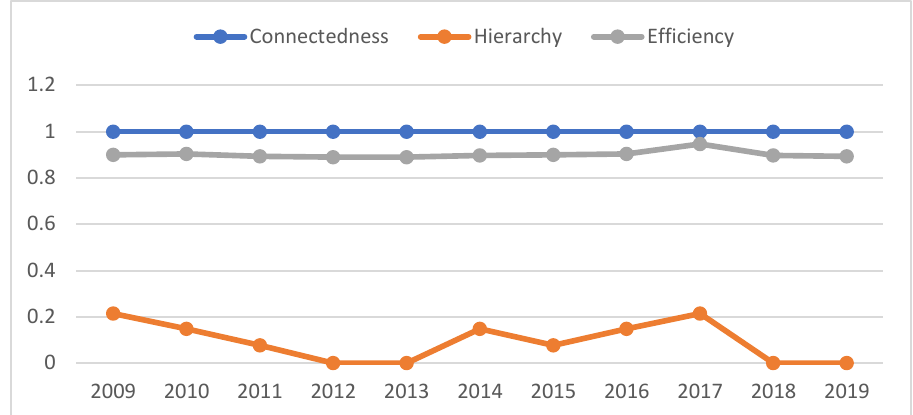
Figure 3. Relevance, hierarchy, and efficiency of the tourism eco-efficiency network.